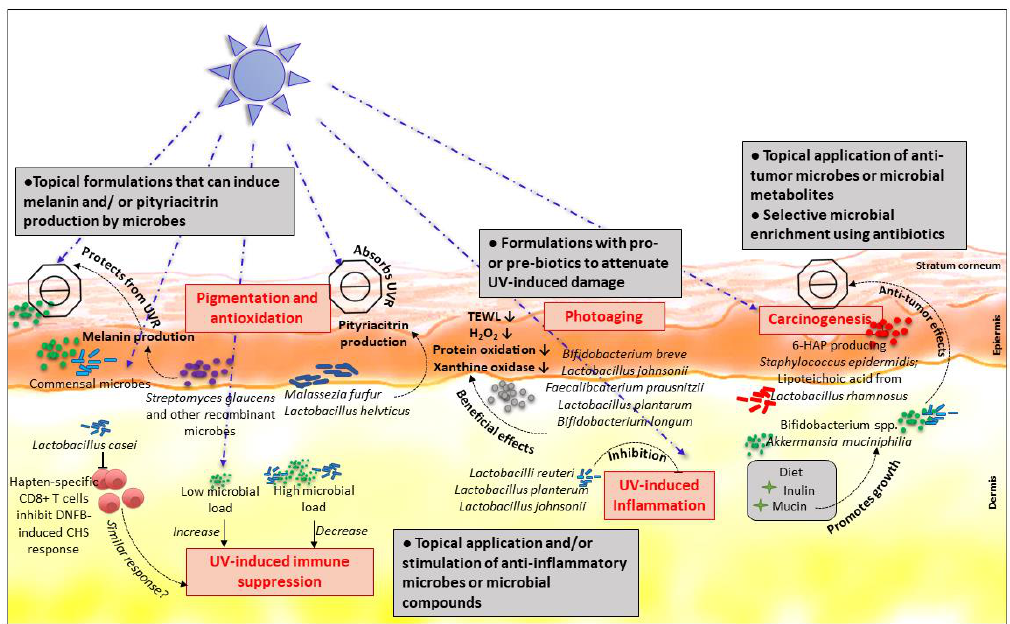
Figure 1. UV-induced e ff ects on the skin and potential treatment strategies using microbes, pro- or pre-biotics. Topical formulations or application of recombinant microbes capable of inducing melanin and / or UV-absorbing compounds such as pityriacitrin could be used for pigmentation and antioxidation. Microbes or pro- or pre-biotics that can prevent and / or reduce UV-induced increase of transepidermal water loss (TEWL), hydrogen peroxide (H 2 O 2 ) levels, oxidation of proteins and xanthine oxidase activity can have beneficial e ff ects on photoaging. Novel strategies such as selective microbial enrichment using topical antibiotics, and / or application of anti-tumor, anti-inflammatory microbes or microbial metabolites / compounds could be beneficial to prevent UV-induced skin cancers and reduce UV-induced skin